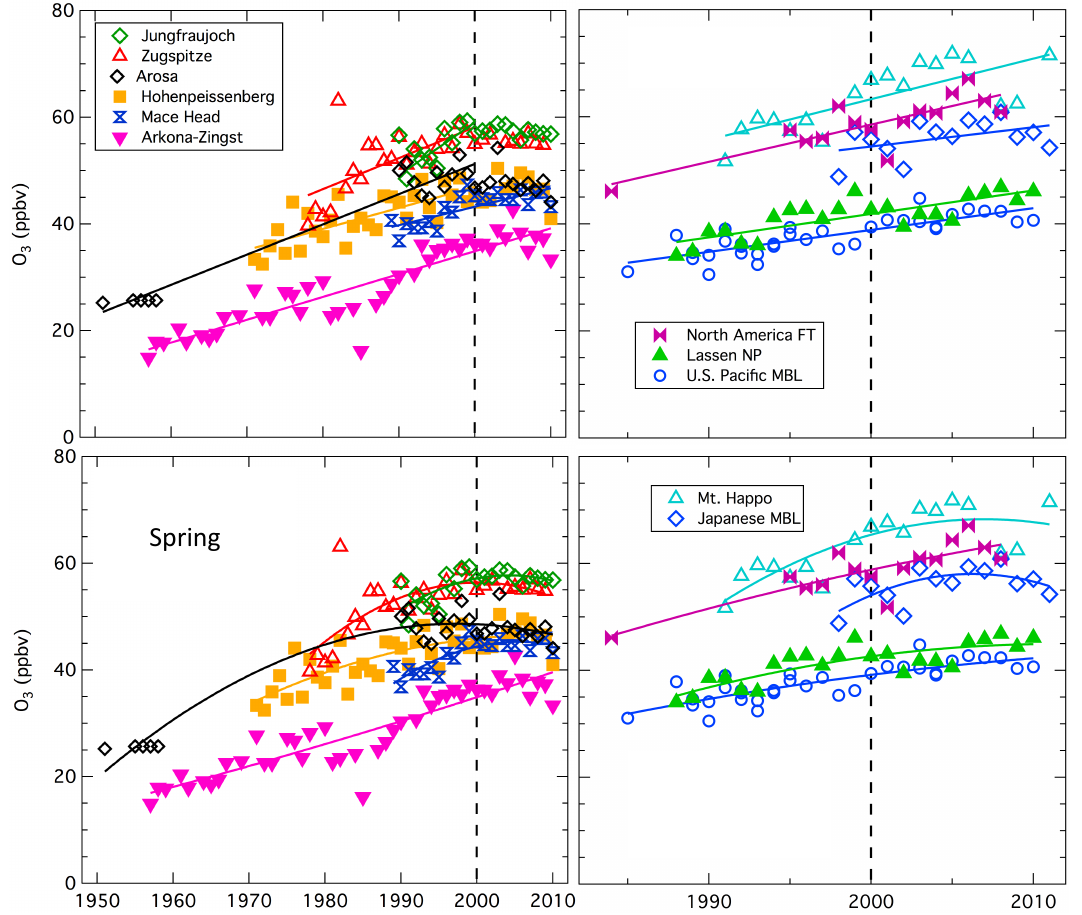
Fig. 5. Comparison of springtime trends in O 3 concentrations measured at all sites in Europe (left panels) and western North America and Japan (right panels). The lines (in color) indicate the linear (upper panels) and quadratic (lower panels) regressions to the